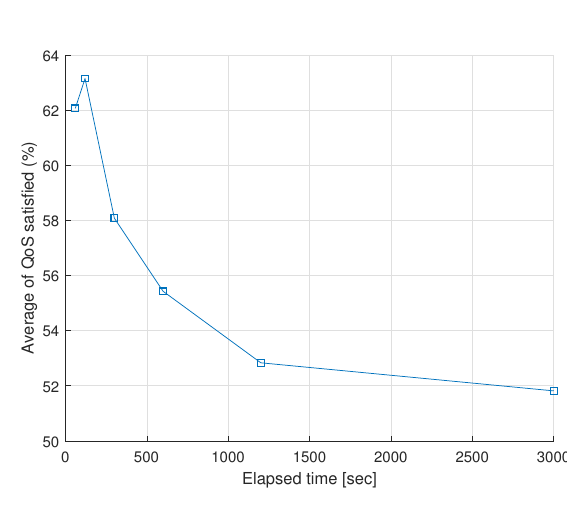
Figure 4. Percentage of QoS